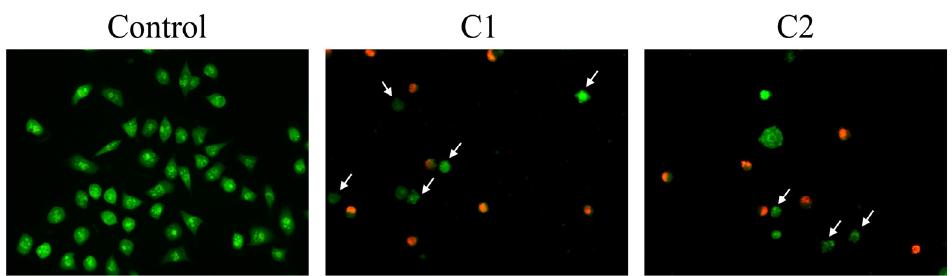
Figure 6. Representative fluorescence photomicrographs of acridine orange-ethidium bromide- stained HeLa cells 24 h after treatment with compounds C1 and C2 (detached cells from culture supernatant). Arrows are showing cells with typical signs of apoptosis (rounding, membrane blebbing, and condensed or fragmented nuclei).